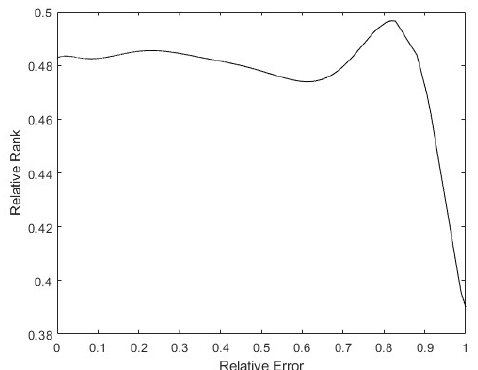
Figure 34. Polynomial regression of relative rank to relative error on X 4 .